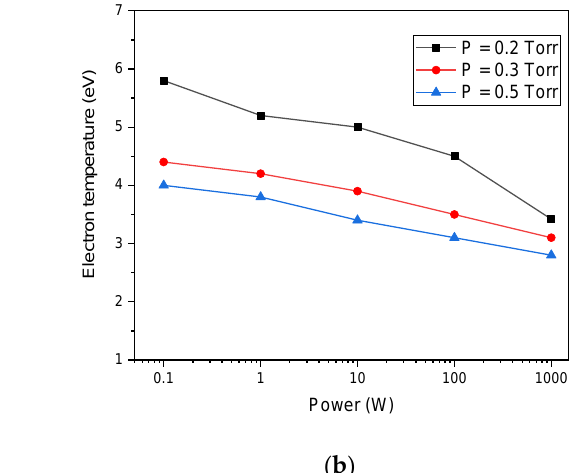
( b ) Figure 13. ( a ) Density and ( b ) electron temperature as a function of input power in Ar/O 2 and He/O 2 at (20%) O 2 and (0.3 Torr) pressure.